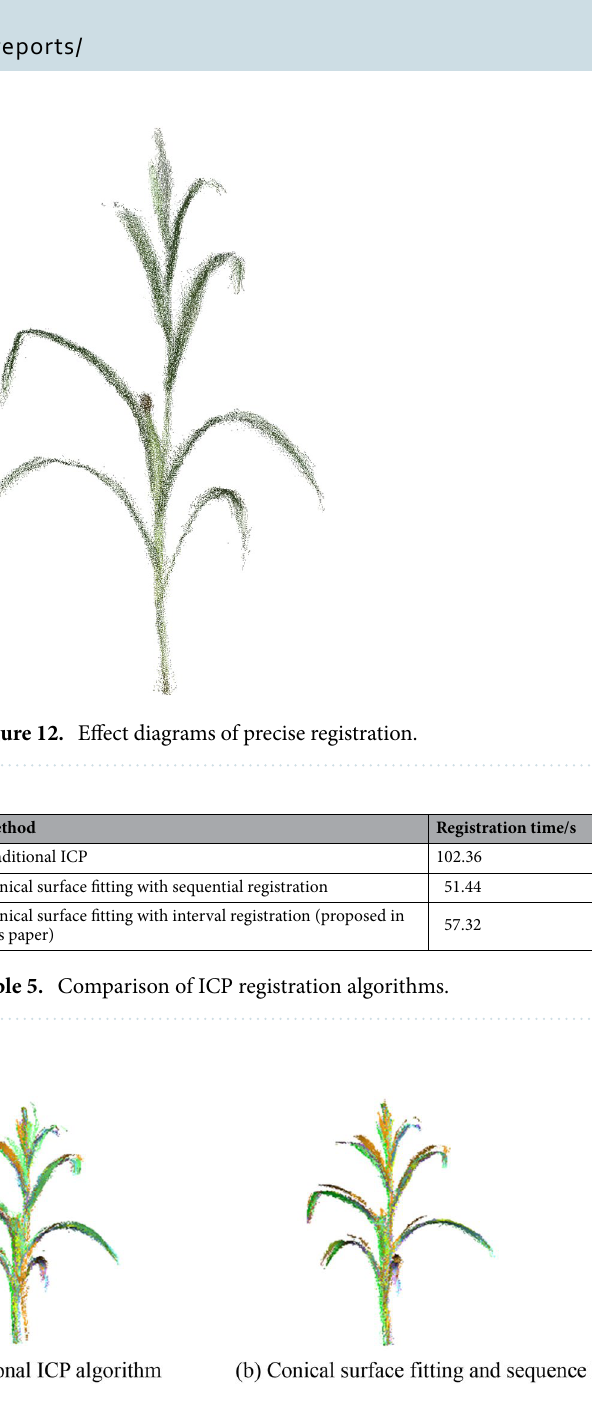
Figure 13. Comparison of registration results of three methods.